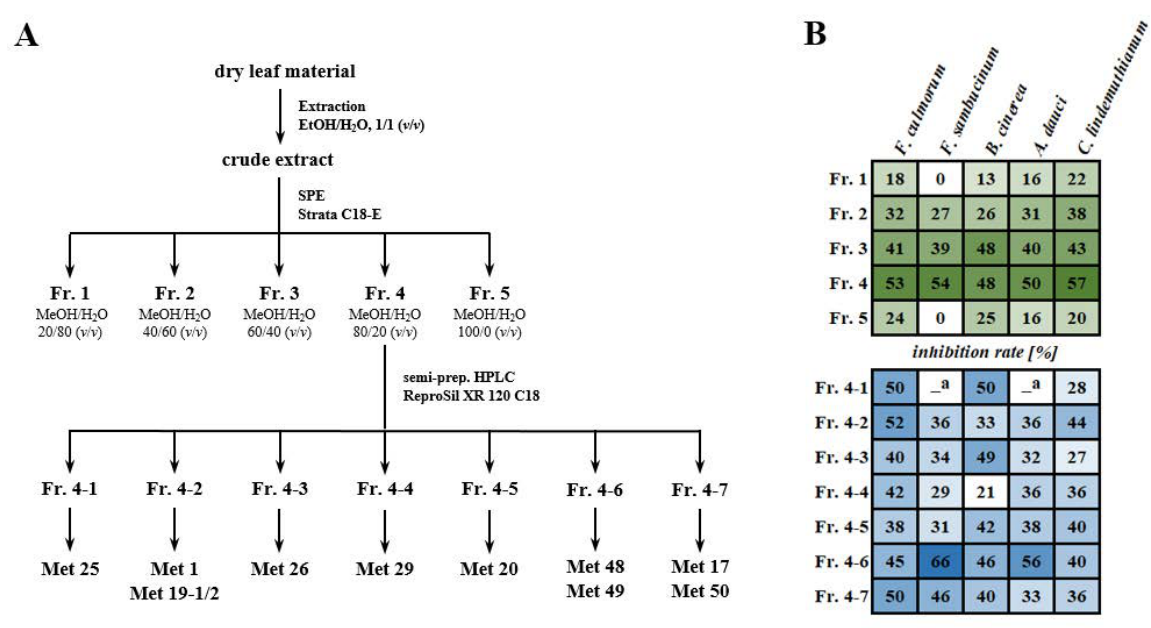
Figure 4. Schematic representation of the bioassay-guided fractionation of a hydroethanolic extract of a pooled leaf sample of the Konar Siah population ( A ); antifungal effects of the fractions obtained ( B ). The antifungal assays of fractions 1 to 5 were performed in 9 cm Petri dishes using test solutions in ethanol/water, 1/1 ( v / v ) with a concentration of 10 mg/mL. Due to limited substance amounts, fractions 4-1 to 4-7 were assayed in 4 cm Petri dishes at a concentration of 1 mg/mL. Shown inhibition rates are means of three replicates and reflected by a heatmap. Darker green or blue colors correspond to higher inhibition rates. The complete data set and statistical analyses are given in Supplementary Table S2. a Assay not performed due to limited substance amounts.